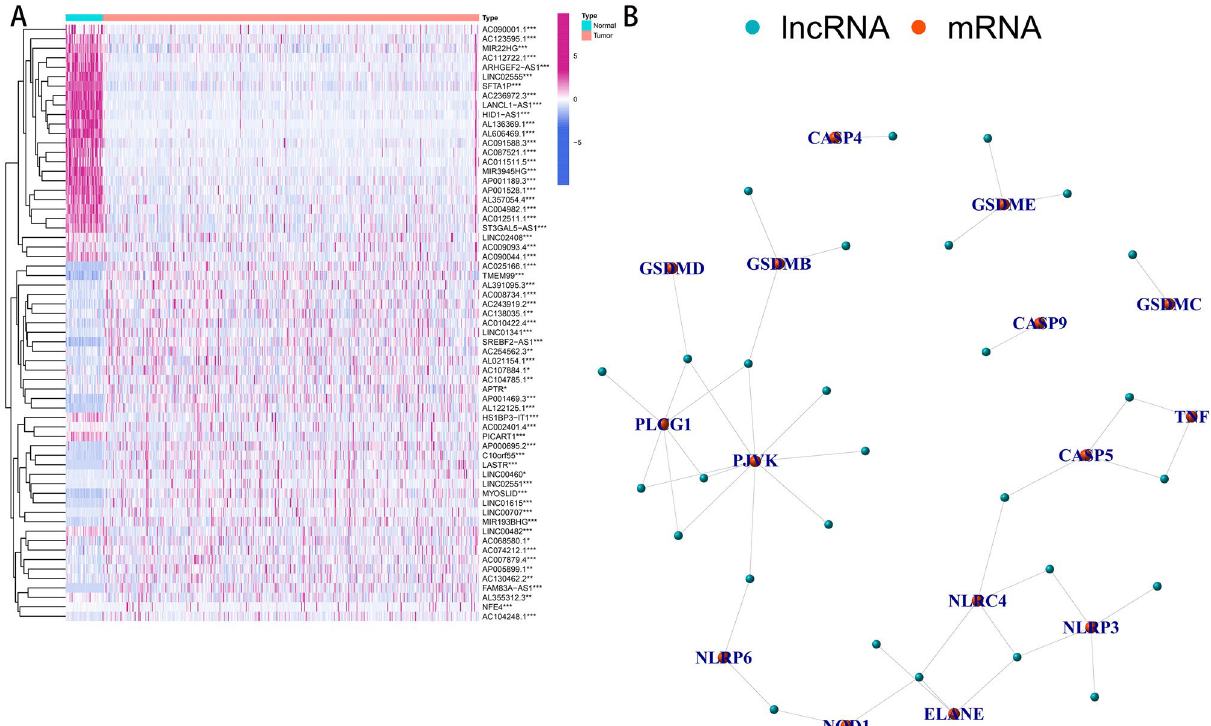
Figure 1. Identification of pyroptosis-related lncRNAs in LSCC patients. ( A ) Heatmap for expression of pyroptosis-related lncRNAs in normal and tumor tissue. ( B ) Gene co-expression network of candidate lncRNAs and pyroptosis-related genes. lncRNA long non-coding RNAs, LSCC lung squamous cell